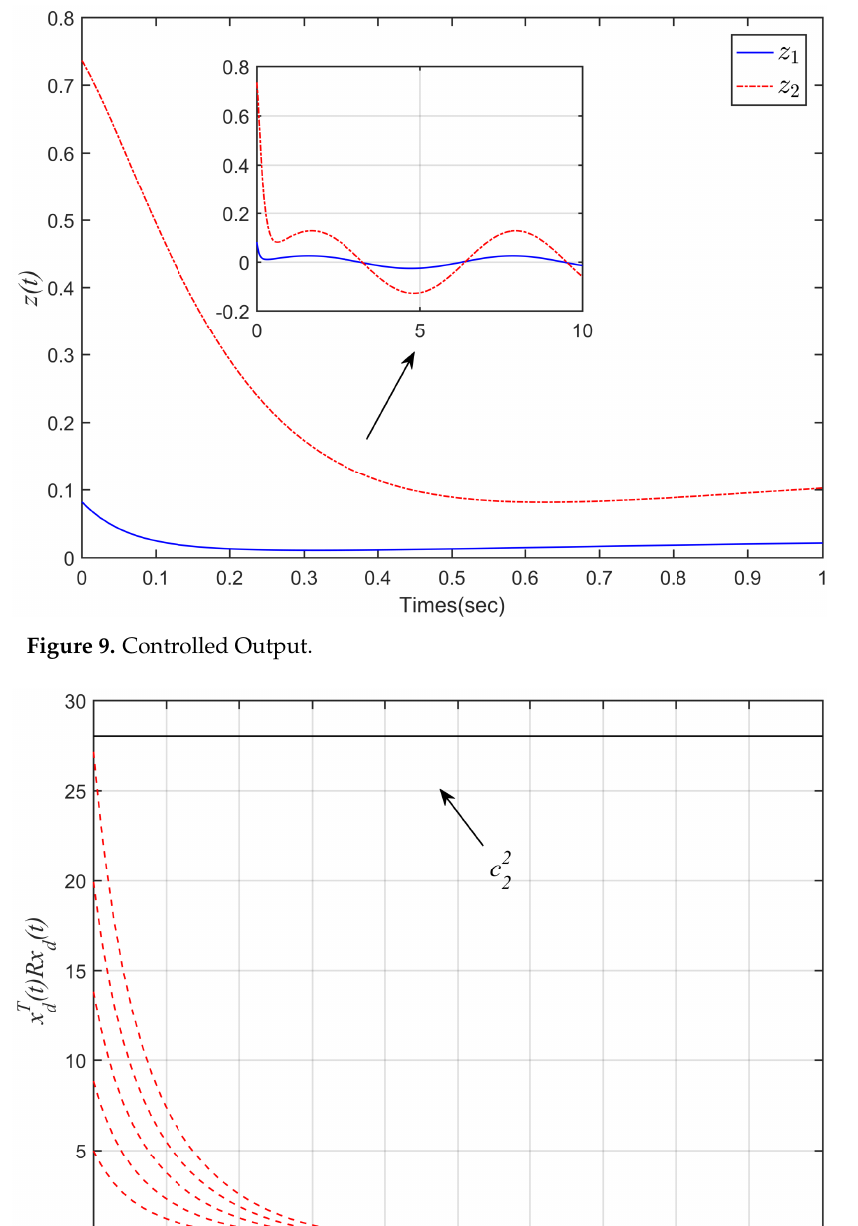
Figure 10. Responses of x T